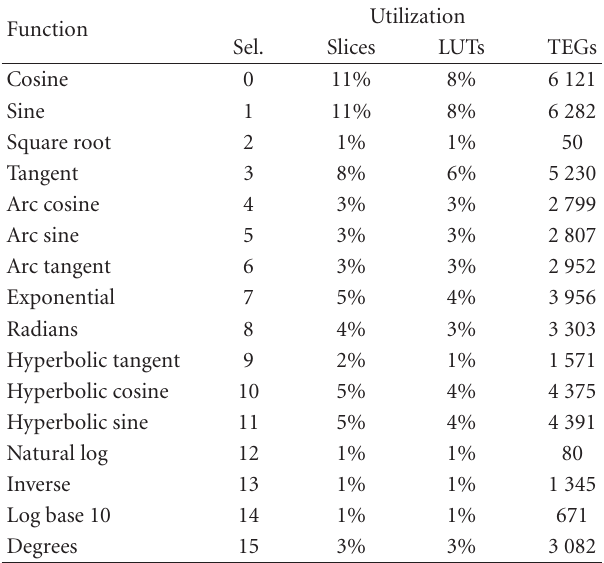
Table 3: Utilization of the mathematical unit